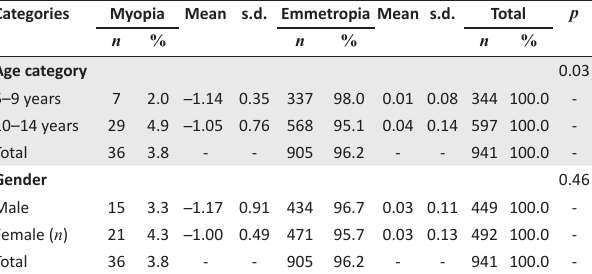
TABLE 4: Chi-square analysis between age categories, gender and myopia. Categories Myopia Mean s.d. Emmetropia Mean